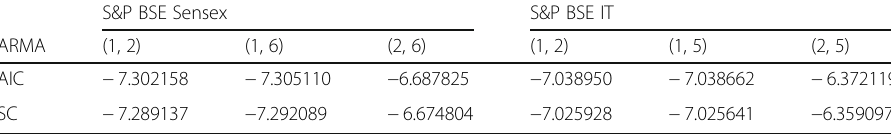
Table 4 AIC and SC values for S&P BSE Sensex and S&P BSE IT (different significance combinations) S&P BSE Sensex S&P BSE IT ARMA (1, 2) (1, 6) (2, 6) (1, 2) (1, 5) (2, 5)